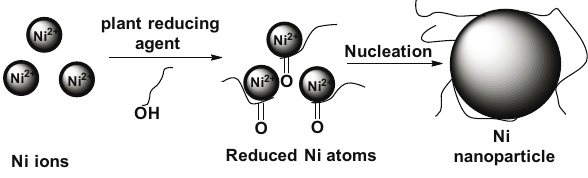
Figure 4: Scheme of reaction mechanism of Ni